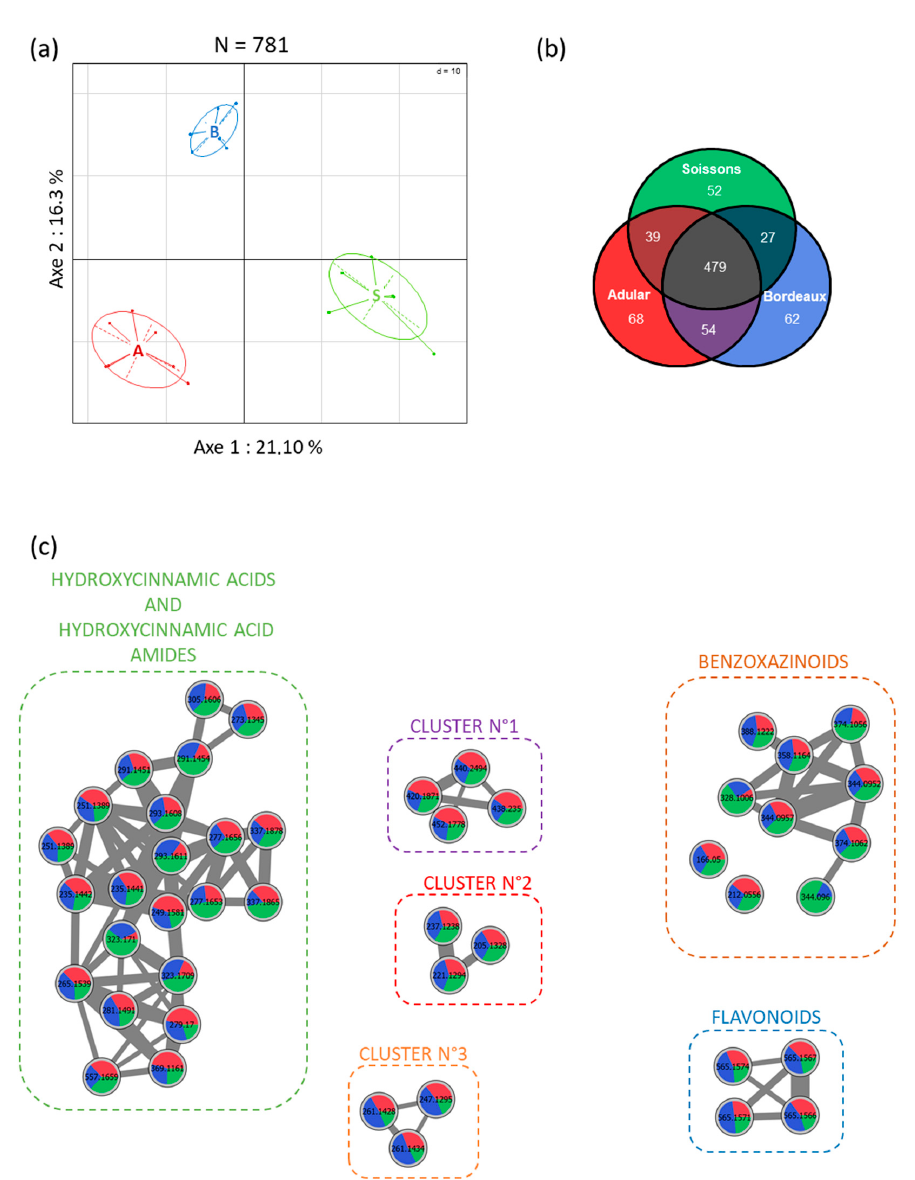
Figure 1. Principal component analysis obtained from LC-HRMS profiles of root extracts of the three wheat genotypes. Secondary metabolomes of wheat roots are displayed following PC1 = 21.1% and PC2 = 16.3% ( n = 21 samples; 781 molecular ions) ( a ). The Venn diagram represents the significantly overproduced wheat metabolite ions according to the wheat genotypes ( p ≤ 0.05; a Kruskal-Wallis nonparametric test corrected for false discovery; n = 7 replicates) ( b ). Generation of a molecular network from MS/MS analyses of methanol extract of Adular, Bordeaux and Soissons wheat genotypes. Node identification corresponds to the masses of parent ions [M+H] and the pie charts show the production of metabolites according to the wheat genotypes. In order to enhance visibility, only clusters with more than three nodes were kept on the molecular network ( c